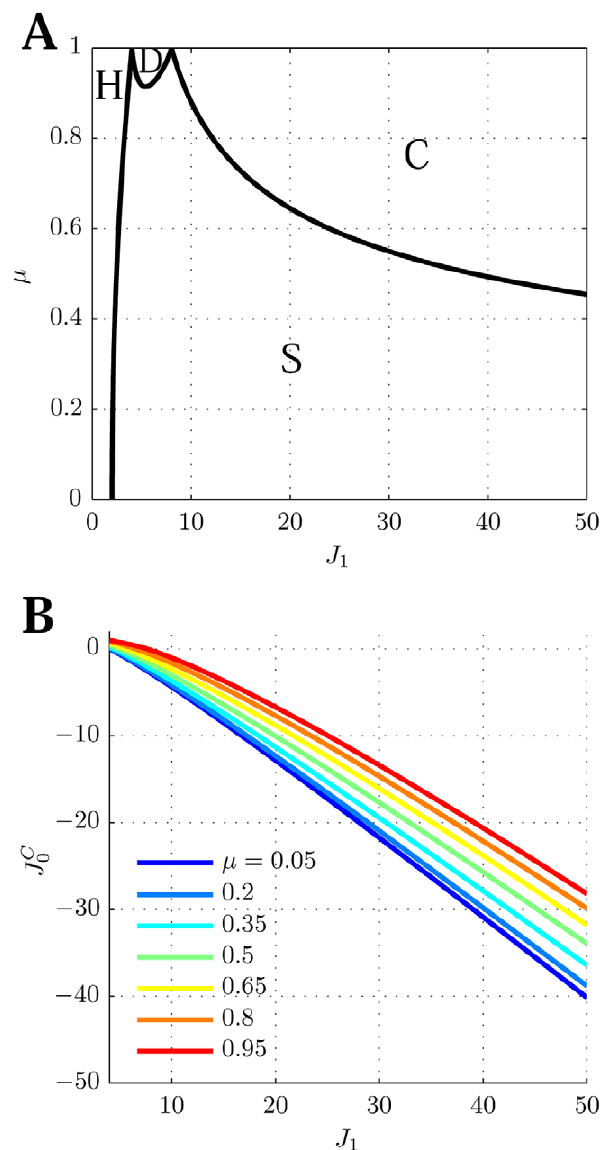
Figure 3. Phase diagram. A: MF solutions in a network storing two correlated maps. The black curves in the J 1 , m parameter space depict the separation between the qualitatively different solutions of the system. Homogeneous solution (denoted by H in the panel), all the neurons are active at a constant level. Single Ring (S) solution, localized activity in the middle map, the bump can be freely rotated in this map. Double Ring (D) solution, pair of solutions localized either in map A or B . Cylinder (C) solution, the network activity is localized in both maps; compared to the single and double ring solutions, there is an additional freedom in the choice of the location of the bump over r ( y { ). The term cylinder is used because the continuous attractor lives in the space defined by the angle h and a sub-segment of r (with the exception of m ~ 1 , see main text for details). B: Amplitude instability. Critical corresponding to the onset of unstable solutions for inhibition J C 0 varying J 1 . Each curve corresponds to different distances between the maps m .